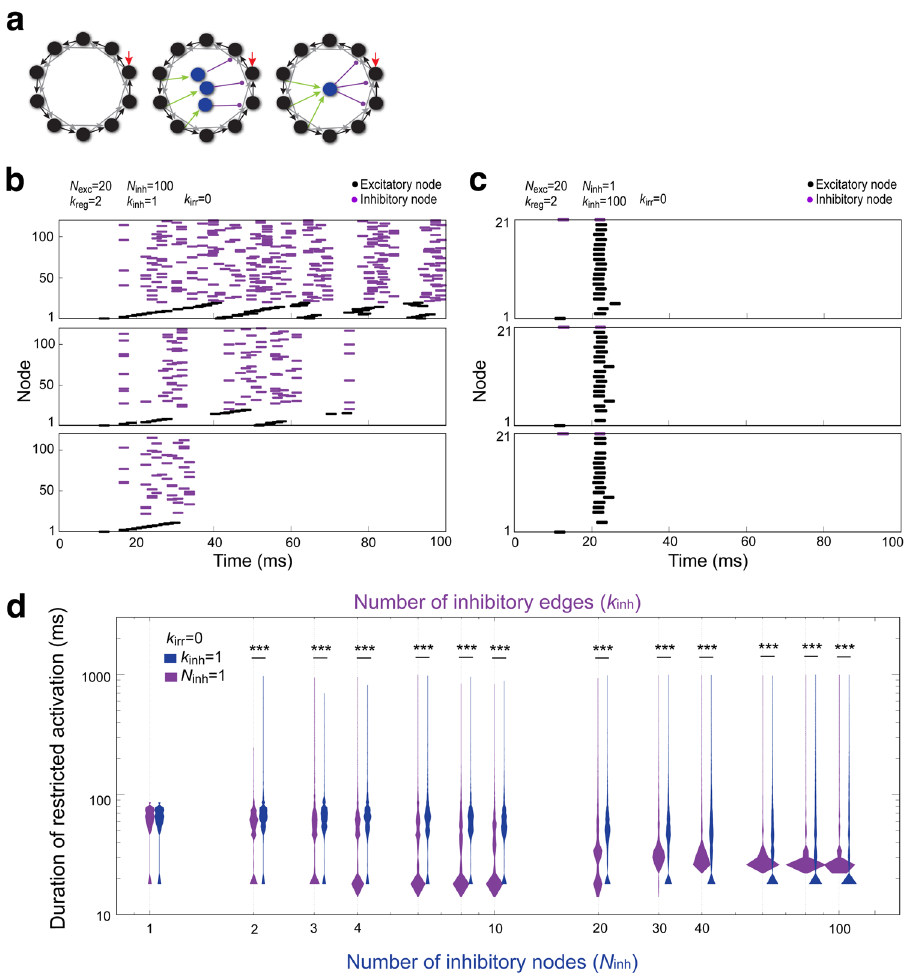
Figure 6. Building excitatory-inhibitory networks by adding inhibitory nodes and edges to simulate LN diversity. ( a ) Left : the basic regular network structure, in which the number of attached inhibitory nodes ( N inh ) and the number of attached inhibitory edges ( k inh ) are 0. Here, the number of irregular edges ( k irr ) of all simulated network structures is 0. Middle : three inhibitory nodes (blue, N inh = 3) are added to the basic network structure, with each receiving a single excitatory supply edge (green) and extending a single inhibitory edge (magenta, k inh = 1). Right : an additional inhibitory node (blue, N inh = 1) is added to the basic network structure, along with three excitatory supply edges (green) and three inhibitory edges (magenta) at k inh = 3. The number of additional excitatory supply edges and the number of inhibitory edges for each node was matched in all simulated networks. ( b , c ) The dynamics of network activation are shown as spike raster plots, when inhibition occurred at lower levels over time ( b ) or when strong inhibition was applied to the system at a single time ( c ). The three plots in each panel show representative data from samples with activation durations in the 75, 50 and 25-percentiles, as shown in the dark blue ( b ) and magenta ( c ) violin plots of ( d ). ( d ) The duration of restricted activation ( ∈ [15,1000]) from 5000 simulated network structures with different N inh at a set value of k inh = 1, or 5000 simulated network structures with different k inh in a network with a set value of N inh = 1 are shown as blue or magenta violin plots, respectively. Statistically significant differences were identified among groups of k inh = 1 and among groups of N inh = 1 by the Kruskal-Wallis H -test ( p < 0.0001, Table S2). In addition, statistically significant differences between the two groups (e.g. k inh = 1 and N inh = 1) were found with the Mann–Whitney U -test. Only those comparisons with significant differences are indicated. * p < 0.05, ** p < 0.01, *** p < 0.001 (Table